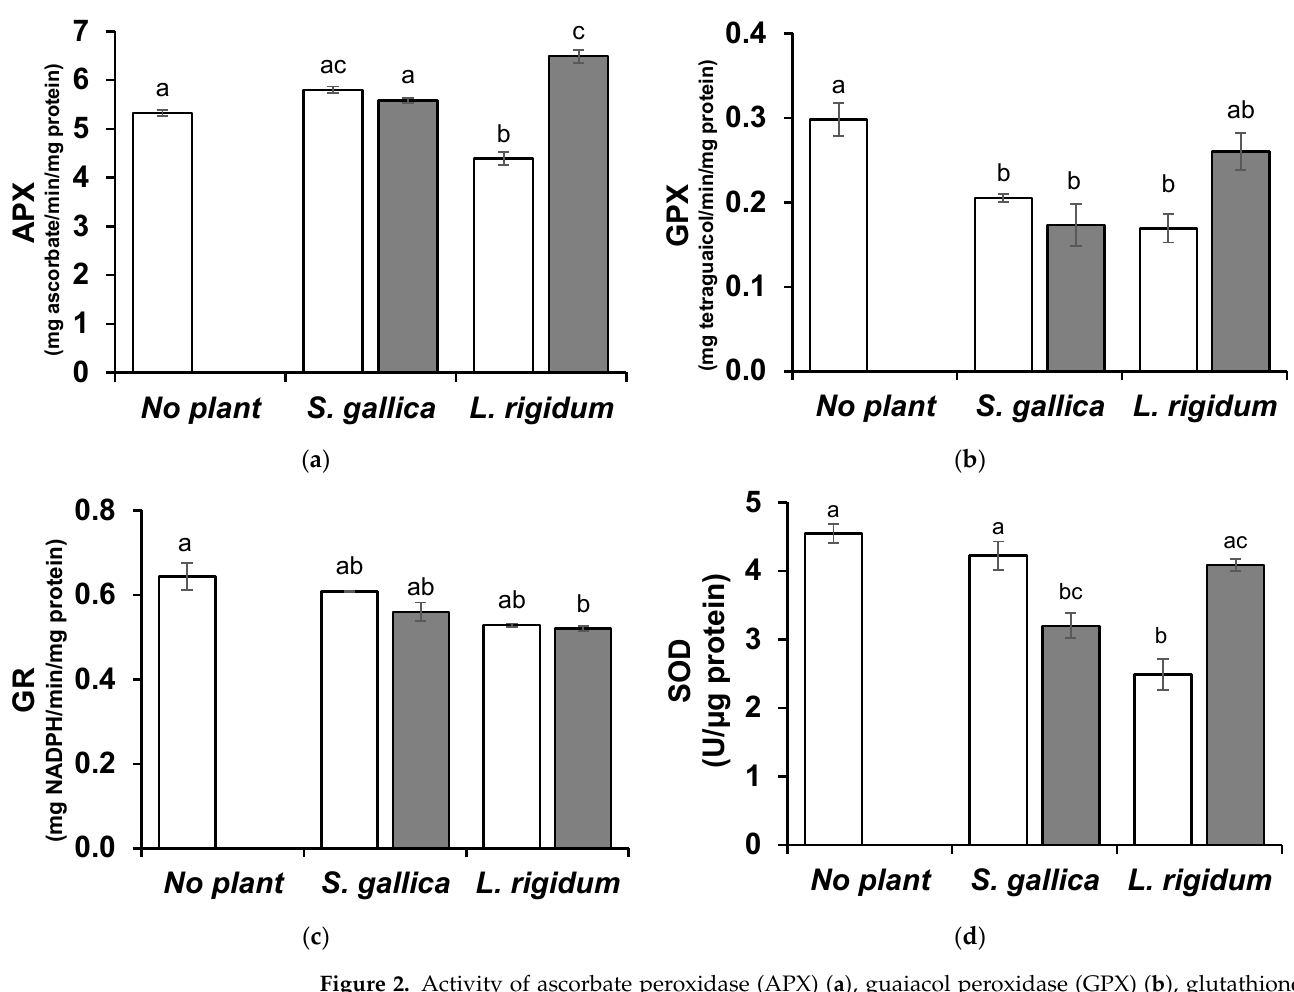
Figure 2. Activity of ascorbate peroxidase (APX) ( a ), guaiacol peroxidase (GPX) ( b ), glutathione reductase (GR) ( c ) and superoxide dismutase (SOD) ( d ) in shoots of 3-week-old wheat grown in disturbed (white columns) and undisturbed (grey columns) acidic soil with arbuscular mycorrhizal fungi associated with previously grown Silene gallica L. (non-mycotrophic) and Lolium rigidum L. (strongly mycotrophic) and with no prior developer, under Mn toxic conditions. Different letters indicate statistically significant differences between the different treatments ( p < 0.05).